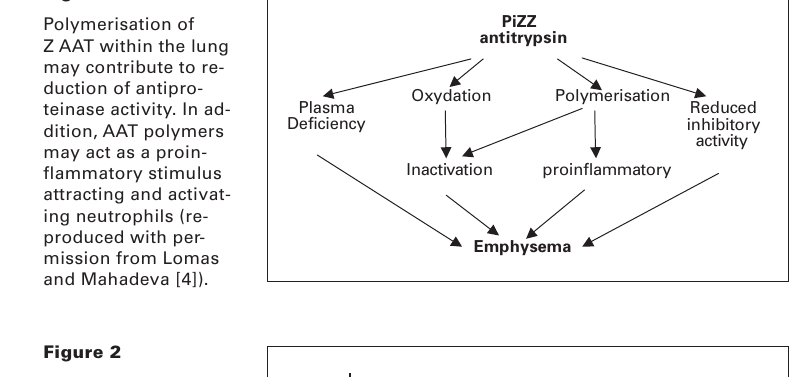
Correlation between AAT blood level and phenotypes (modi- fied based on